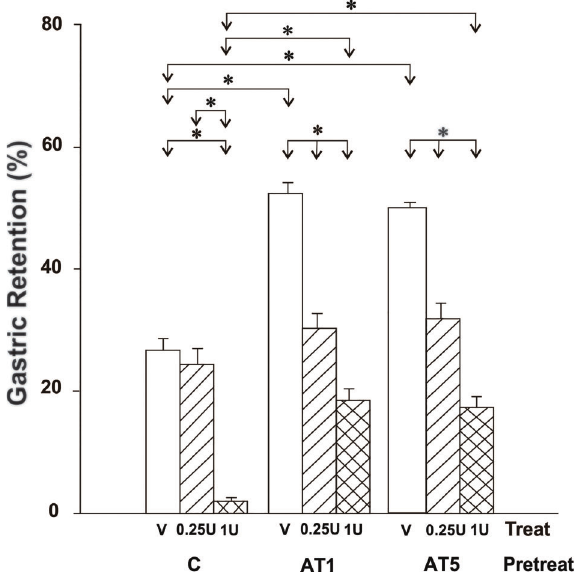
Figure 1. Gastric retention of a saline test meal (2 mL/100 g animal weight), 10 min after administration by gavage to rats. The animals were pretreated (Pretreat) iv with saline (C), 1 or 5 mg/kg atropine sulfate (AT1 and AT5, respectively) and, after 30 min, treated (Treat) iv with vehicle (V), 0.25 U or 1 U/kg insulin (0.25U and 1U, respectively). The test meal was administered 30 min after treatment. Data are reported as means ± SE for 8 animals per group. *P o 0.05 (ANOVA followed by Tukey